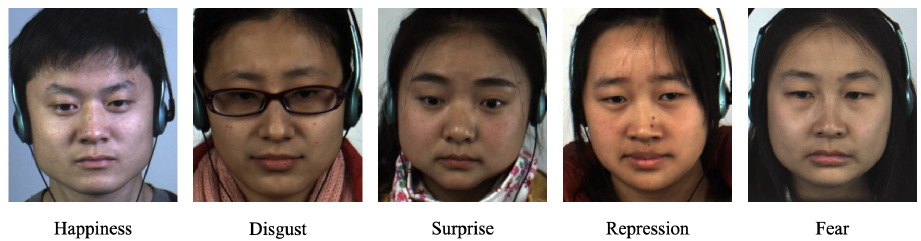
Figure 11. Examples of frames from sequences in the Chinese Academy of Sciences Micro-Expression II (CASME II) data set